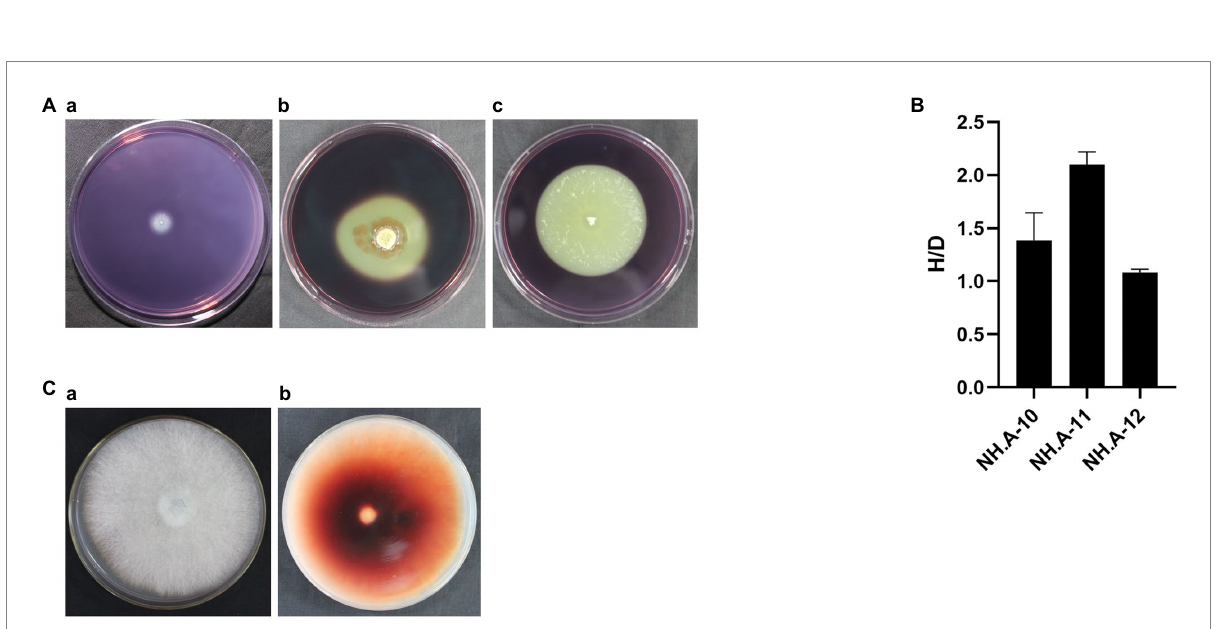
FIGURE 6 Ability of the dominant fungi to degrade cellulose and lignin. (A) Degradation images of dominant fungi. (a) Penicillium (NH. A-10). (b) Aspergillus (NH. A-11). (c) Cerrena (NH. A-12). (B) The preliminary determination of cellulose hydrolase activity was assessed for these three fungi based on the ratio of H and D (H/D). The error bars represented the standard deviation. (C) NH. A-12 grown on the PDA-guaiacol medium at 28 ° C for 5 days showing (a) the front and (b) back side of the